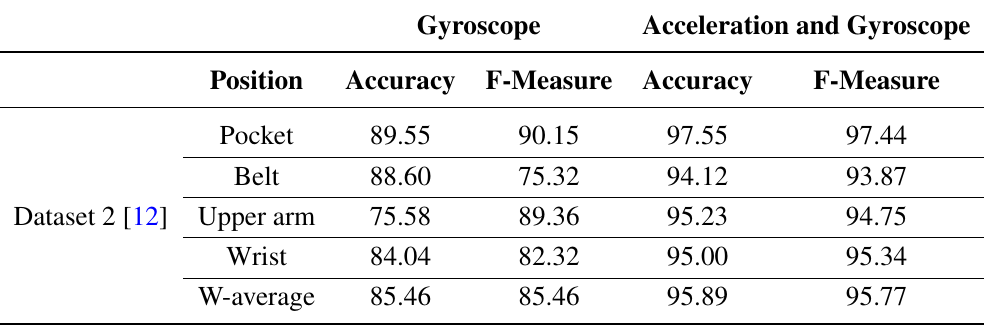
Table 7. Results with the gyroscope and acceleration